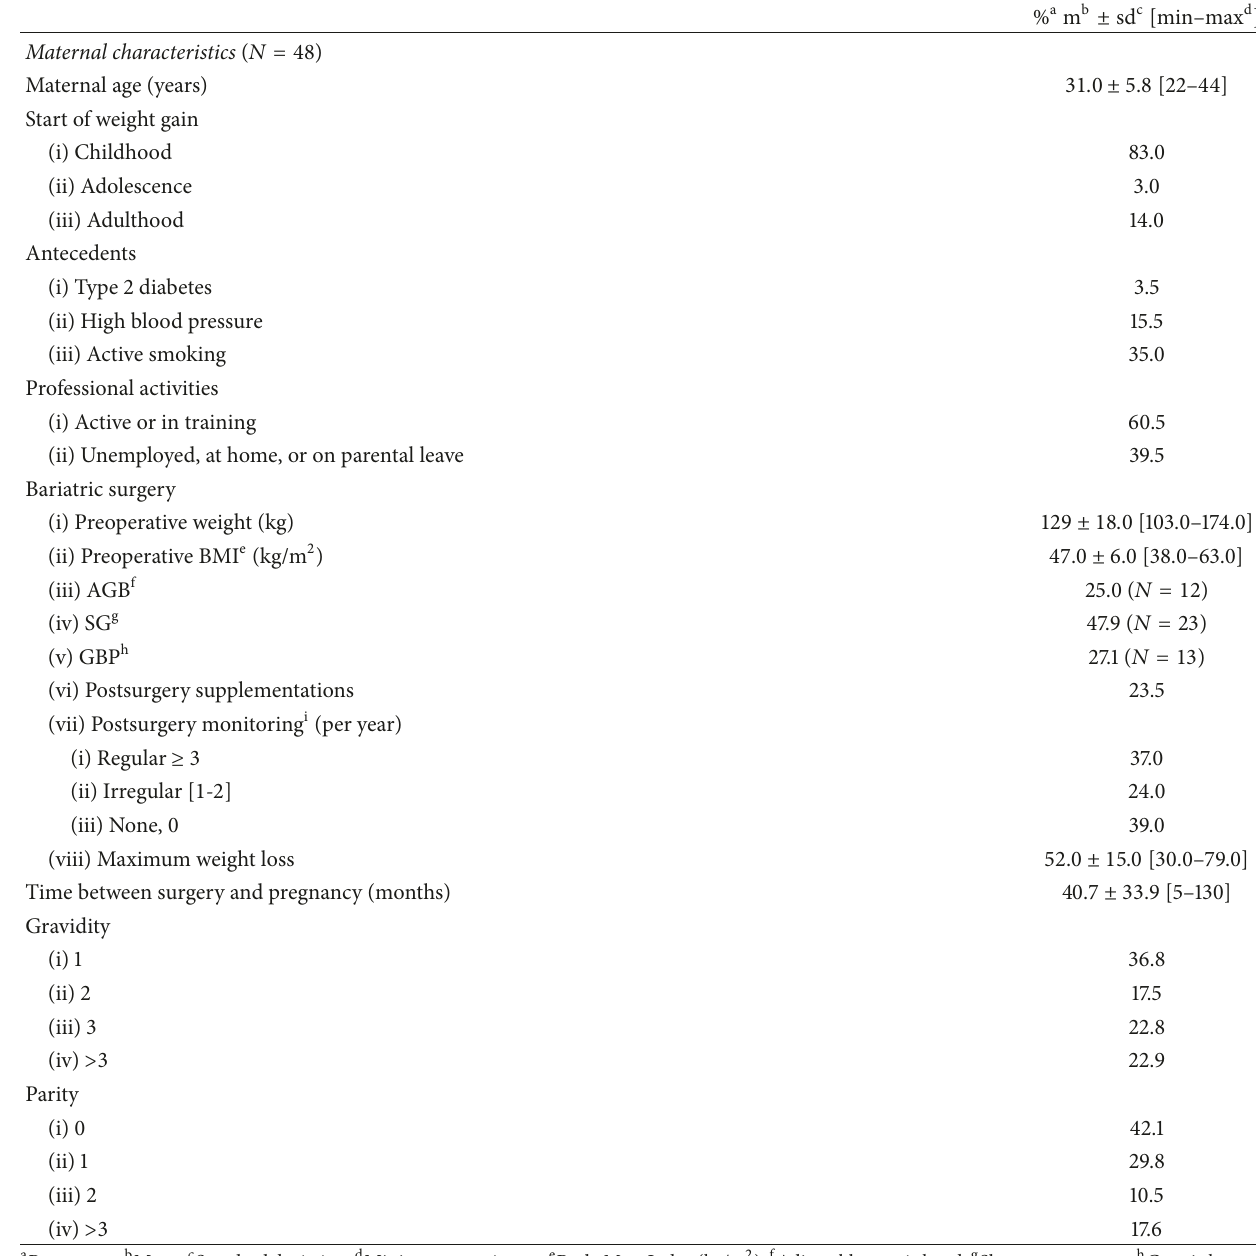
Table 2: Maternal characteristics of 48